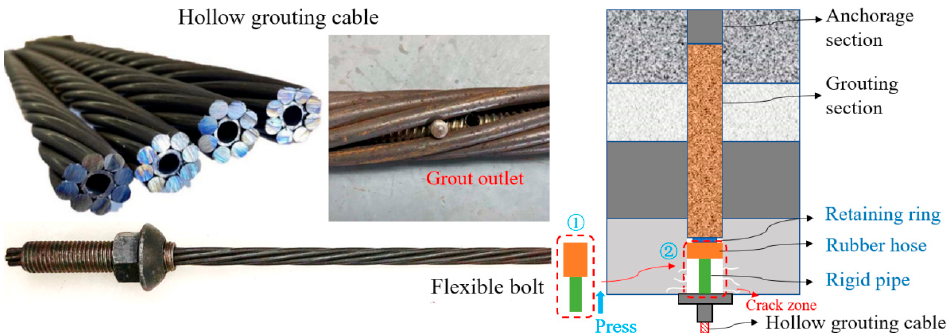
Figure 20. New support products and grouting sealing